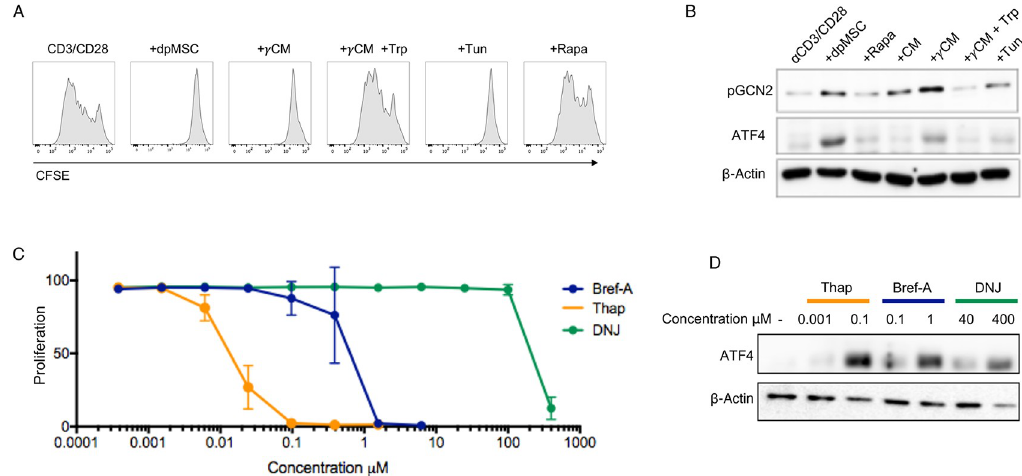
Fig 2. Tryptophan starvation inhibits T-cell proliferation through activation of GCN2 and induction of the cellular stress response. ( A ) Representative histograms showing the proliferation of α CD3/CD28-activated CFSE-labelled CD4 + T-cells co- cultured with dpMSC, conditioning medium from IFN γ licenced IDO + dpMSC cultures ( γ CM) with or without Tryptophan (Trp), Rapamycin (Rapa), or in the presence of the ER-stress inducer Tunicamycin (Tun). Data are representative of at least two independent experiments. ( B ) Representative immunoblot showing the expression of pGCN2 and ATF4 in α CD3/ CD28-activated CD4 + T-cells upon direct co-culture with dpMSC, Rapamycin (Rapa), CM, γ CM in the presence or absence of Tryptophan (Trp) or in the presence of the ER-stress inducer Tunicamycin (Tun). ( C ) Proliferation of α CD3/CD28-activated CD4 + T-cells, as measured by CFSE dilution, in the presence of varying concentrations of three ER-stress inducers (Bref-A, Thap, DNJ). Data are pooled from at least two independent experiments. ( D ) Representative immunoblot showing the expression of ATF4 in α CD3/CD28-activated CD4 + T-cells in response to ER-stress inducing compounds at concentrations that straddle their inhibition of T-cell